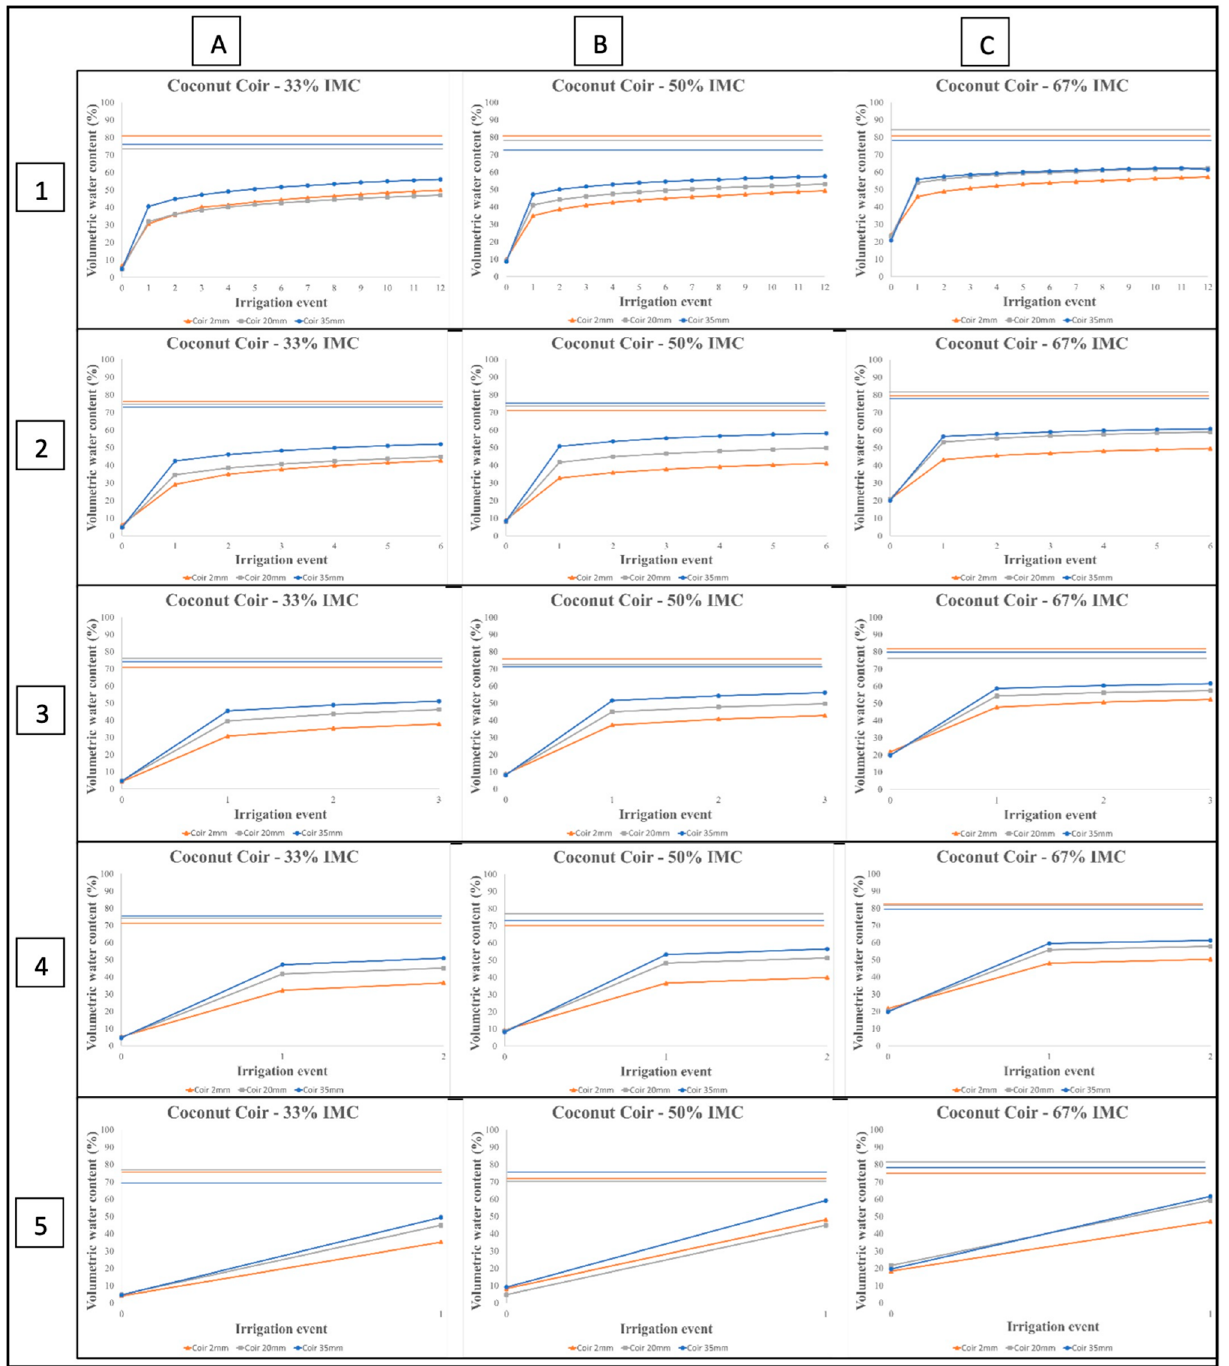
Figure 2. Substrate waters capture volumetric water content curves for coir over three initial moisture contents (IMC) of ( A ) 33%, ( B ) 50%, and ( C ) 67%, three irrigation water levels of 2mm (orange), 20mm (gray), and 35mm (blue), and at five irrigation pulse durations of 5 min (1), 10 min (2), 20 min (3), 30 min (4), and 60 min (5). The container capacity for each water level is denoted by the color matched solid bar on the figure.